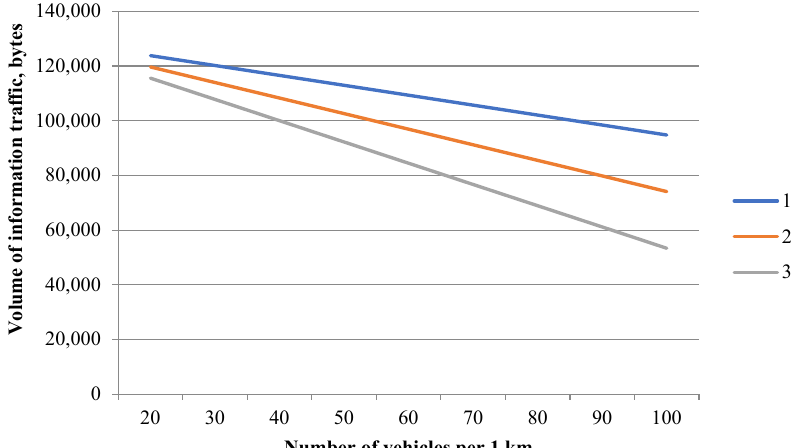
Figure 6. Dependence of the traffic available for transmitting information on the number of OBUs per 1 km (1, 2, and 3—confidentiality levels).